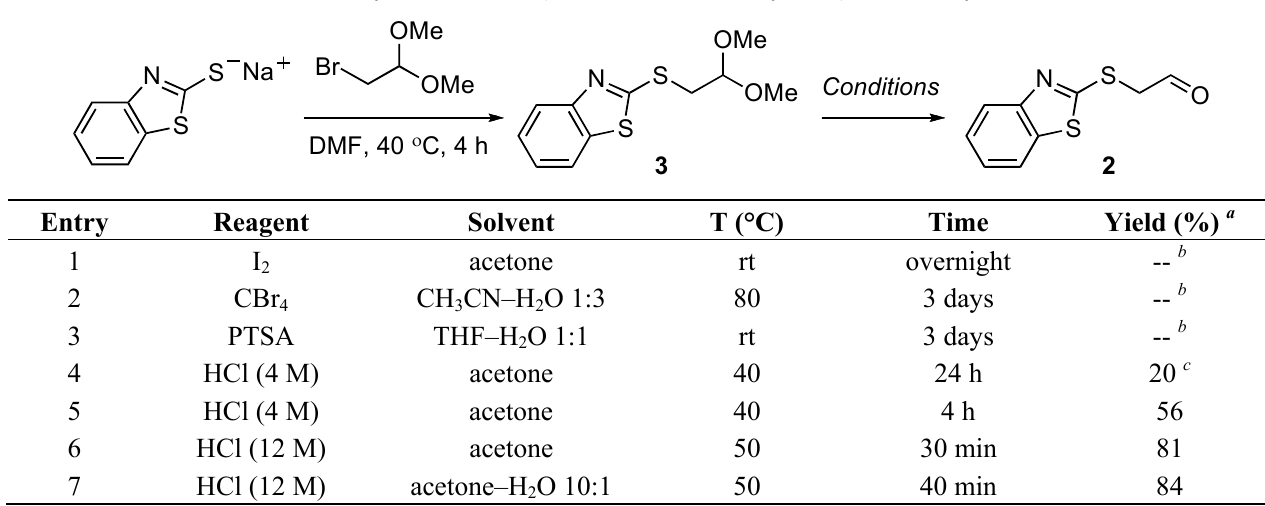
Table 1. Synthesis of 2-(benzo[ d ]thiazol-2-ylthio)acetaldehyde 2